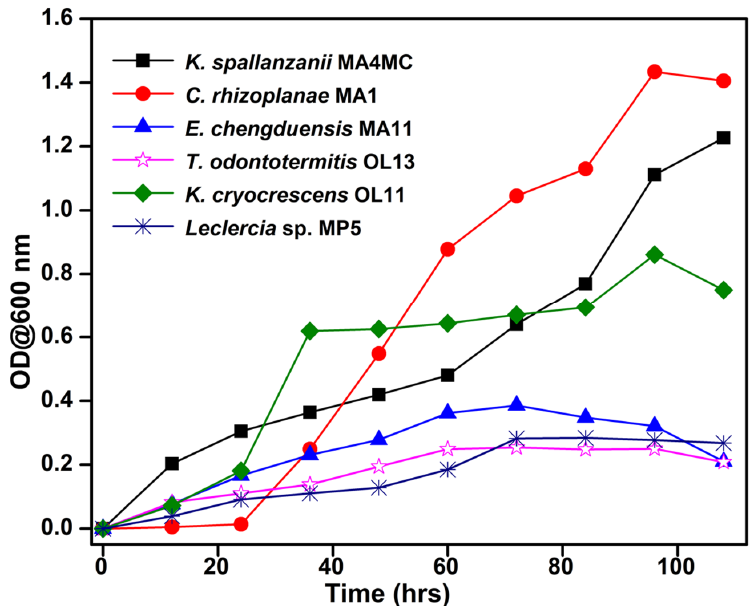
Figure 6. Growth profile of the potential cellulose and hemicellulose degrading bacteria on the BSM media containing 0.5% ( w / v ) of Avicel or xylan as carbon sources. media containing 0.5% ( w / v ) of Avicel or xylan as carbon sources.